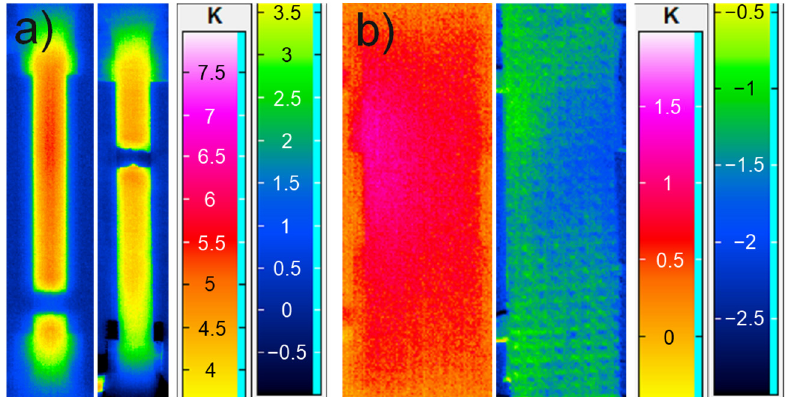
Figure 10. Δ T-thermograms of the ( a ) PPA-GF30 specimens at 23 °C ( left ) and 60 °C ( right ) after failure and ( b ) CFRP specimens 23 °C ( left ) and 60 °C ( right ) after one million cycles in dynamical